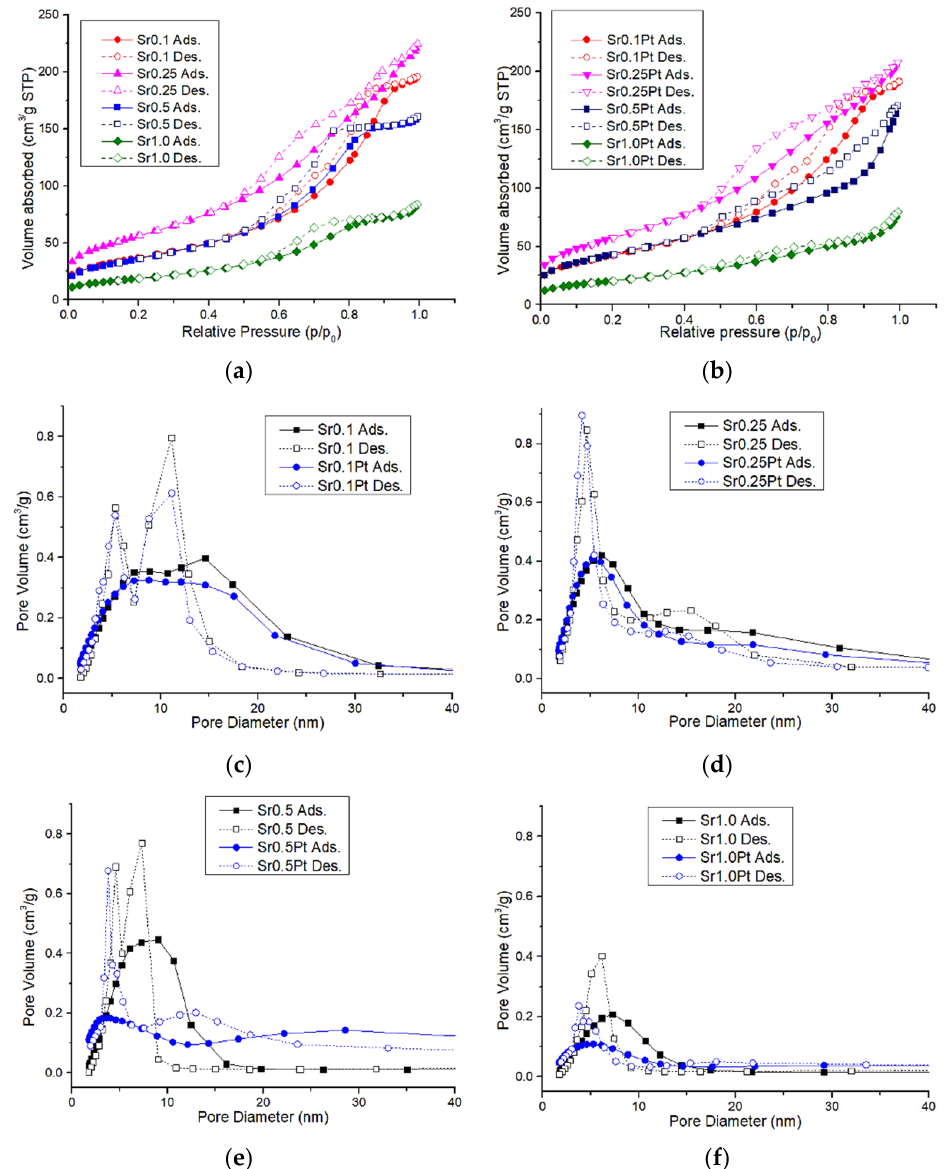
Figure 6. ( a , b ) Isotherm of Al 2 O 3 /SrCO 3 and Pt/Al 2 O 3 -SrCO 3 , ( c – f ) pore volume distribution of Al 2 O 3 /SrCO 3 and Pt/Al 2 O 3 -SrCO 3 .